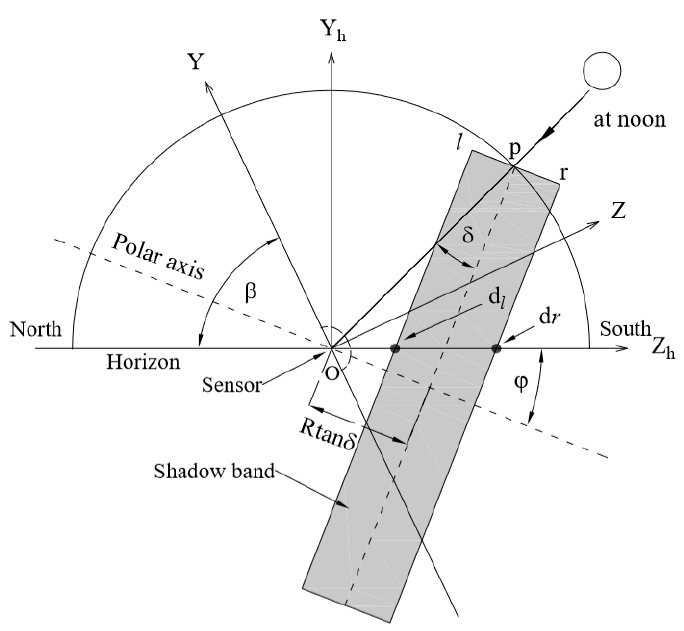
Figure 2. Diagram of shadow band placement in the horizontal coordinate system at δ (cid:54) = 0 and ϕ (cid:54) = 0. (2) The area S in Equation (1) and in the equatorial coordinate system shown as in Figure 3 at δ = 0 is easily obtained and calculated by Equation (43). In the other situations shown as Figure 4 at δ (cid:54) = 0, the area S can be calculated by coordinate translations. However, all possibilities have to be considered and